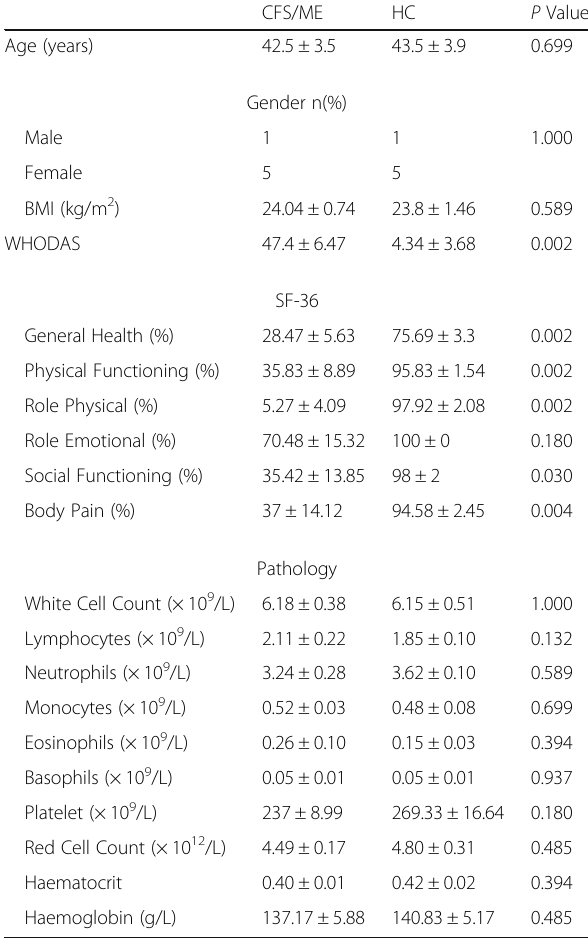
Table 1 Blood parameters and patient demographic. SF-36 scores were analysed using participant questionnaire responses. Results from routine full blood analysis in CFS/ME patients and